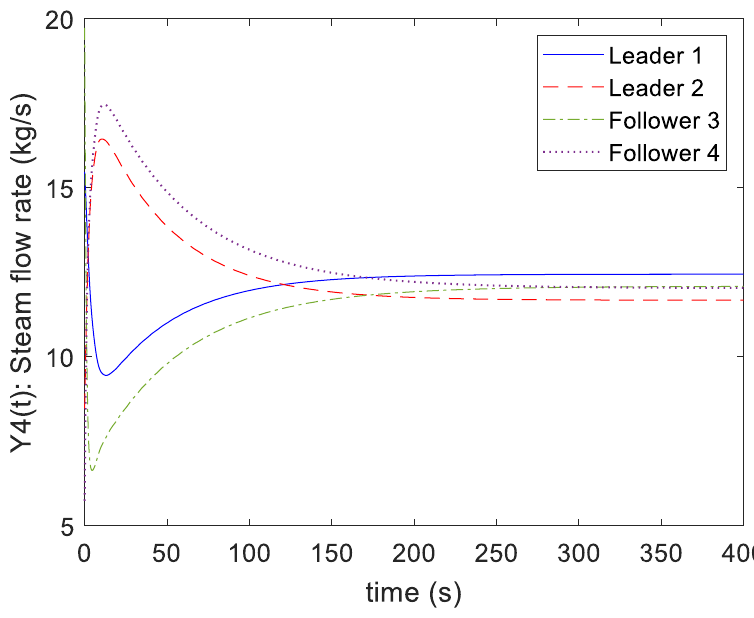
  Y t with type-1 fuzzy control. 3